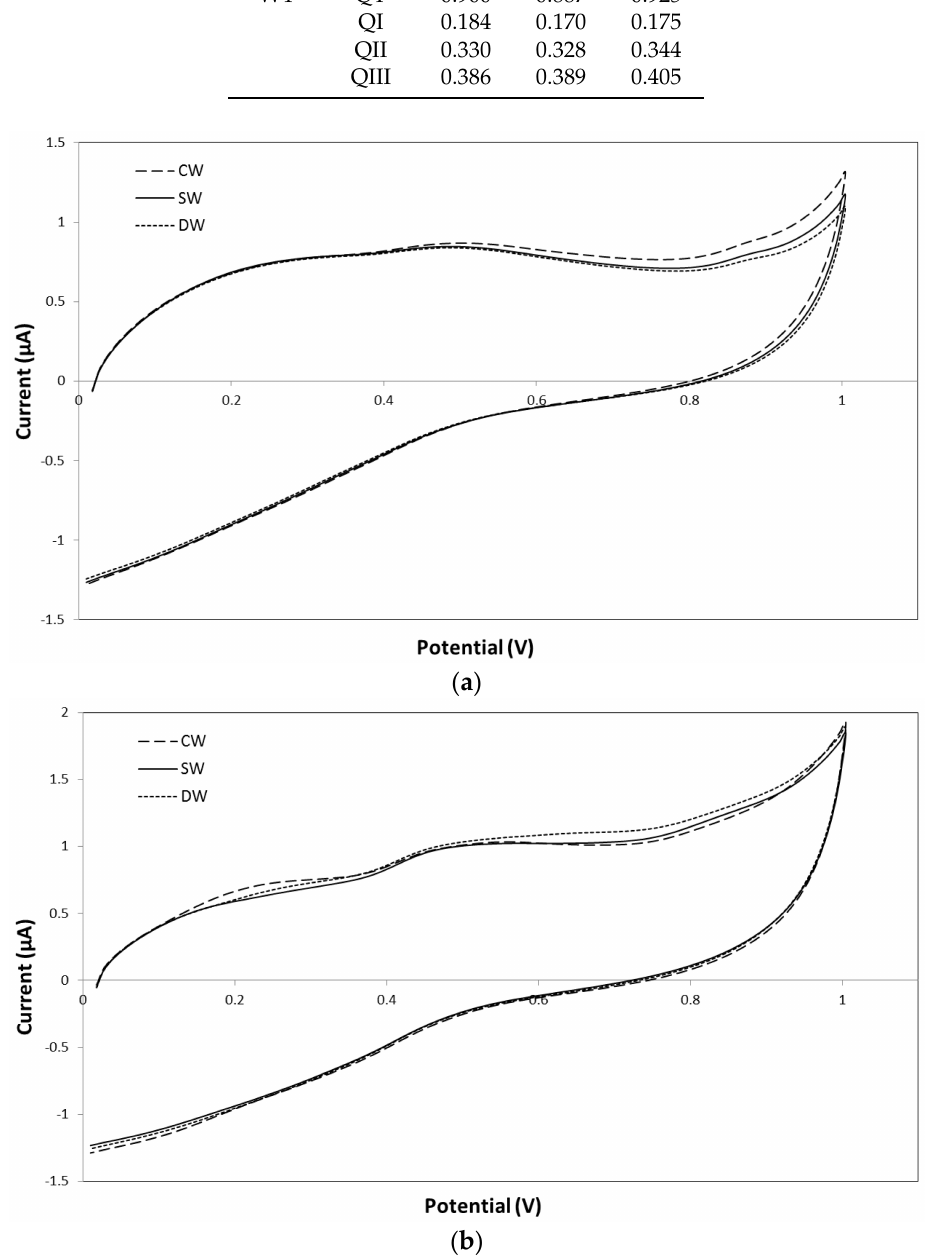
Figure 3. Cyclic voltammograms of CW, SW, and DW at different stages: ( a ) stage I; ( b ) stage W4. Regarding QT, CW had higher values at stage I than SW and DW samples (0.740 versus 0.708 and 0.693, respectively). The area under the curve can be related to the concentration of total phenols [43]; therefore, these